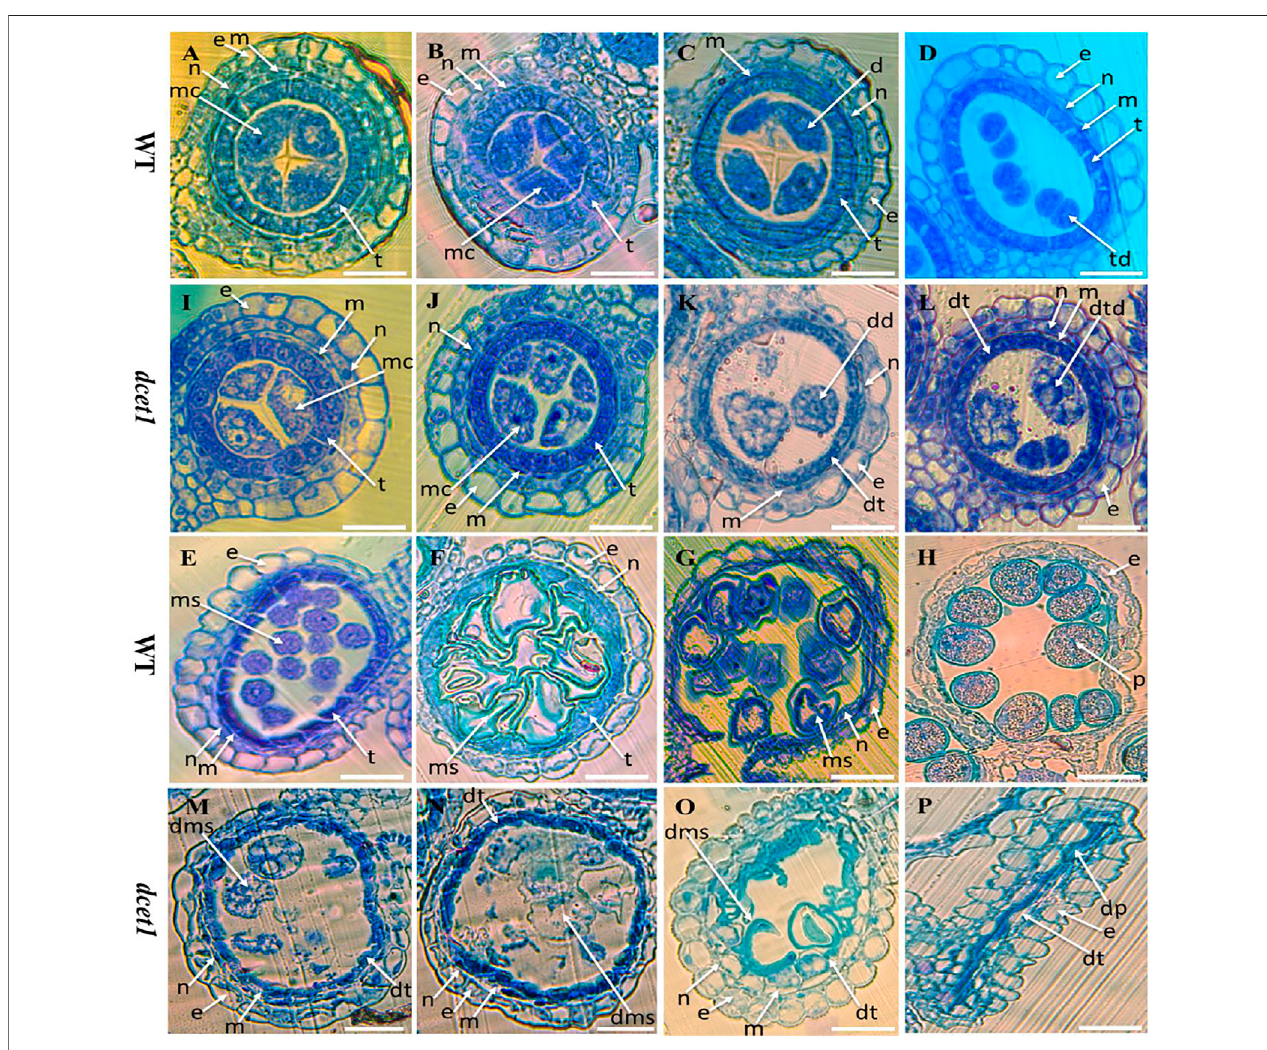
FIGURE 2 | Semi-section analysis of wild-type (WT) and mutant ( dcet1 ). Anther sections of WT (A – H) and dcet1 (I – P) from stages 6 – 10 and 12 and 13 of anther development, respectively. e, epidermis ; n, endothecium; m, middle layer; t, tapetum; mc, meiocyte; dt, defective tapetum; d, dyad; dd, defective dyad; td, tetrad; dtd, defective tetrad; ms, microspore; dms, defective microspore; p, pollen; dp, defective pollen. Scale bars (cid:1) 15